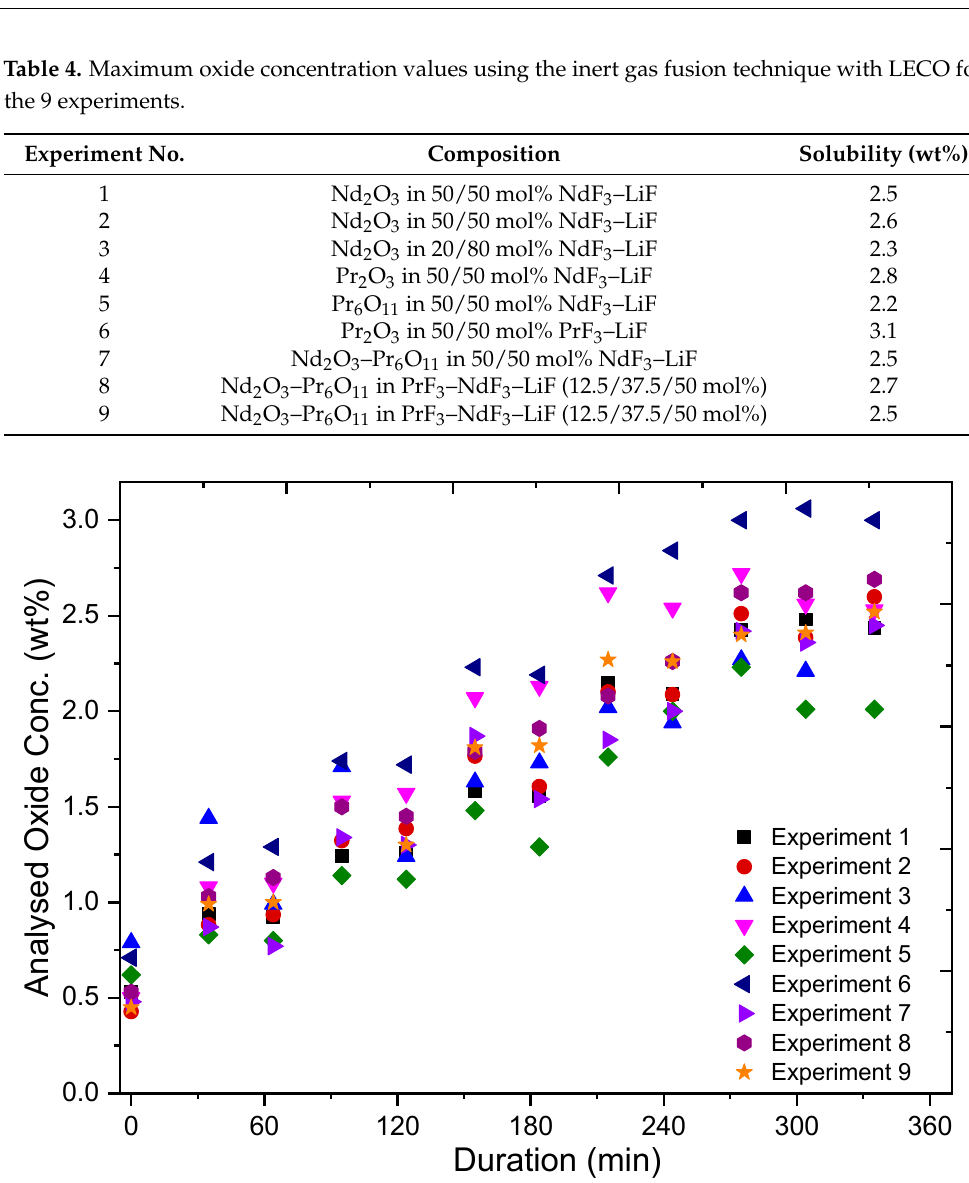
Figure 2. Analysed oxide concentration of electrolyte measured with the LECO apparatus for the electrolyte sampled at 30 min intervals for all the 9 experiments.